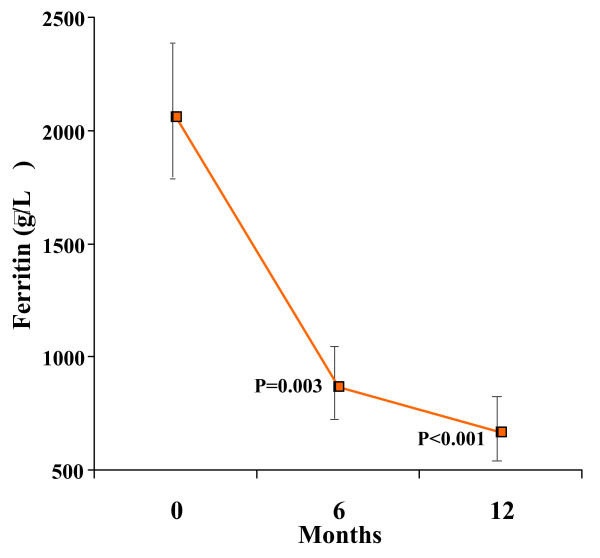
There was a significant reduction in serum ferritin over 12 months. The vertical axis shows the geometric mean of ferritin. Standard error bars are shown. The p values shown are post-hoc analyses for 0–6 months, and 0–12 months.